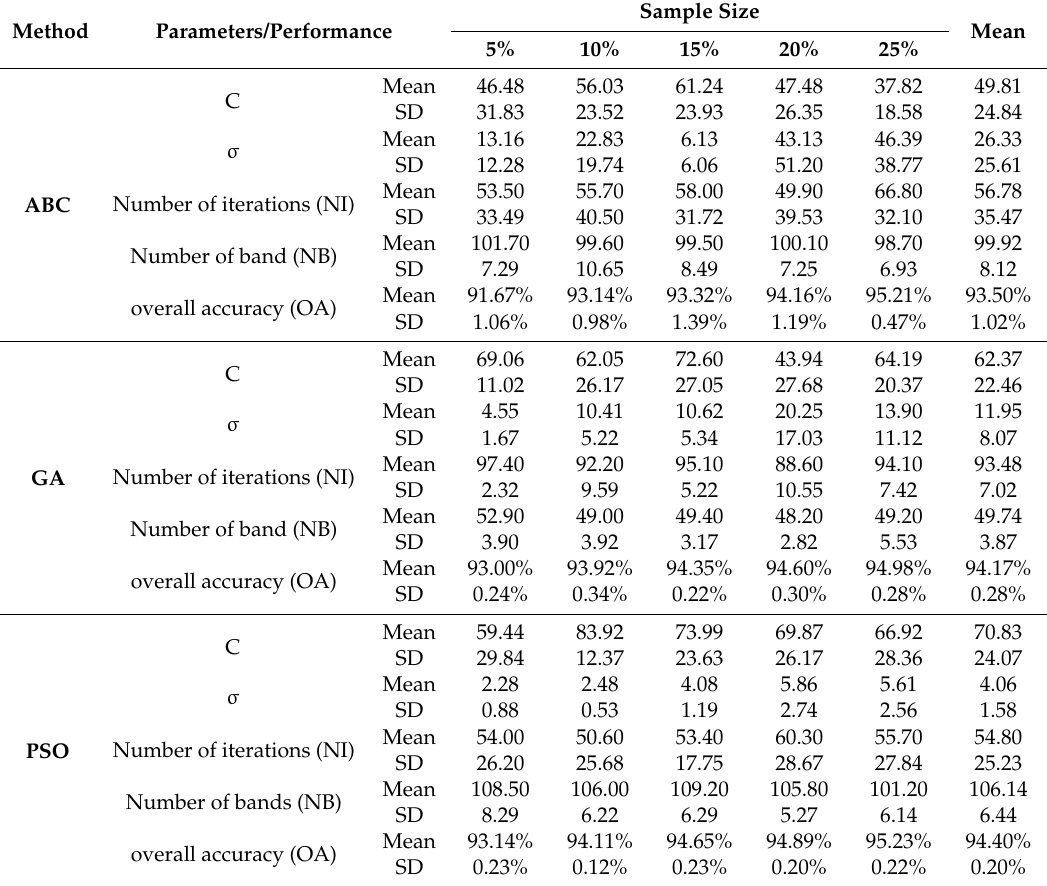
Table 3. Classification parameters and performance of the Salinas